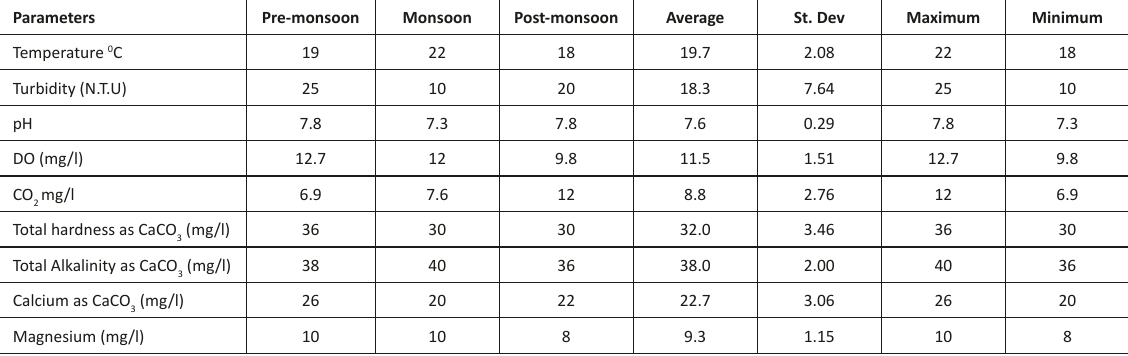
Table 1. Water quality parameters of Garanga wetland studied during the year 2010